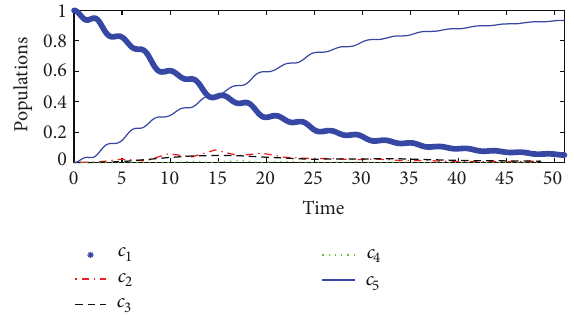
Figure 4: The population of the system state by the Lyapunov control without impulsive control.